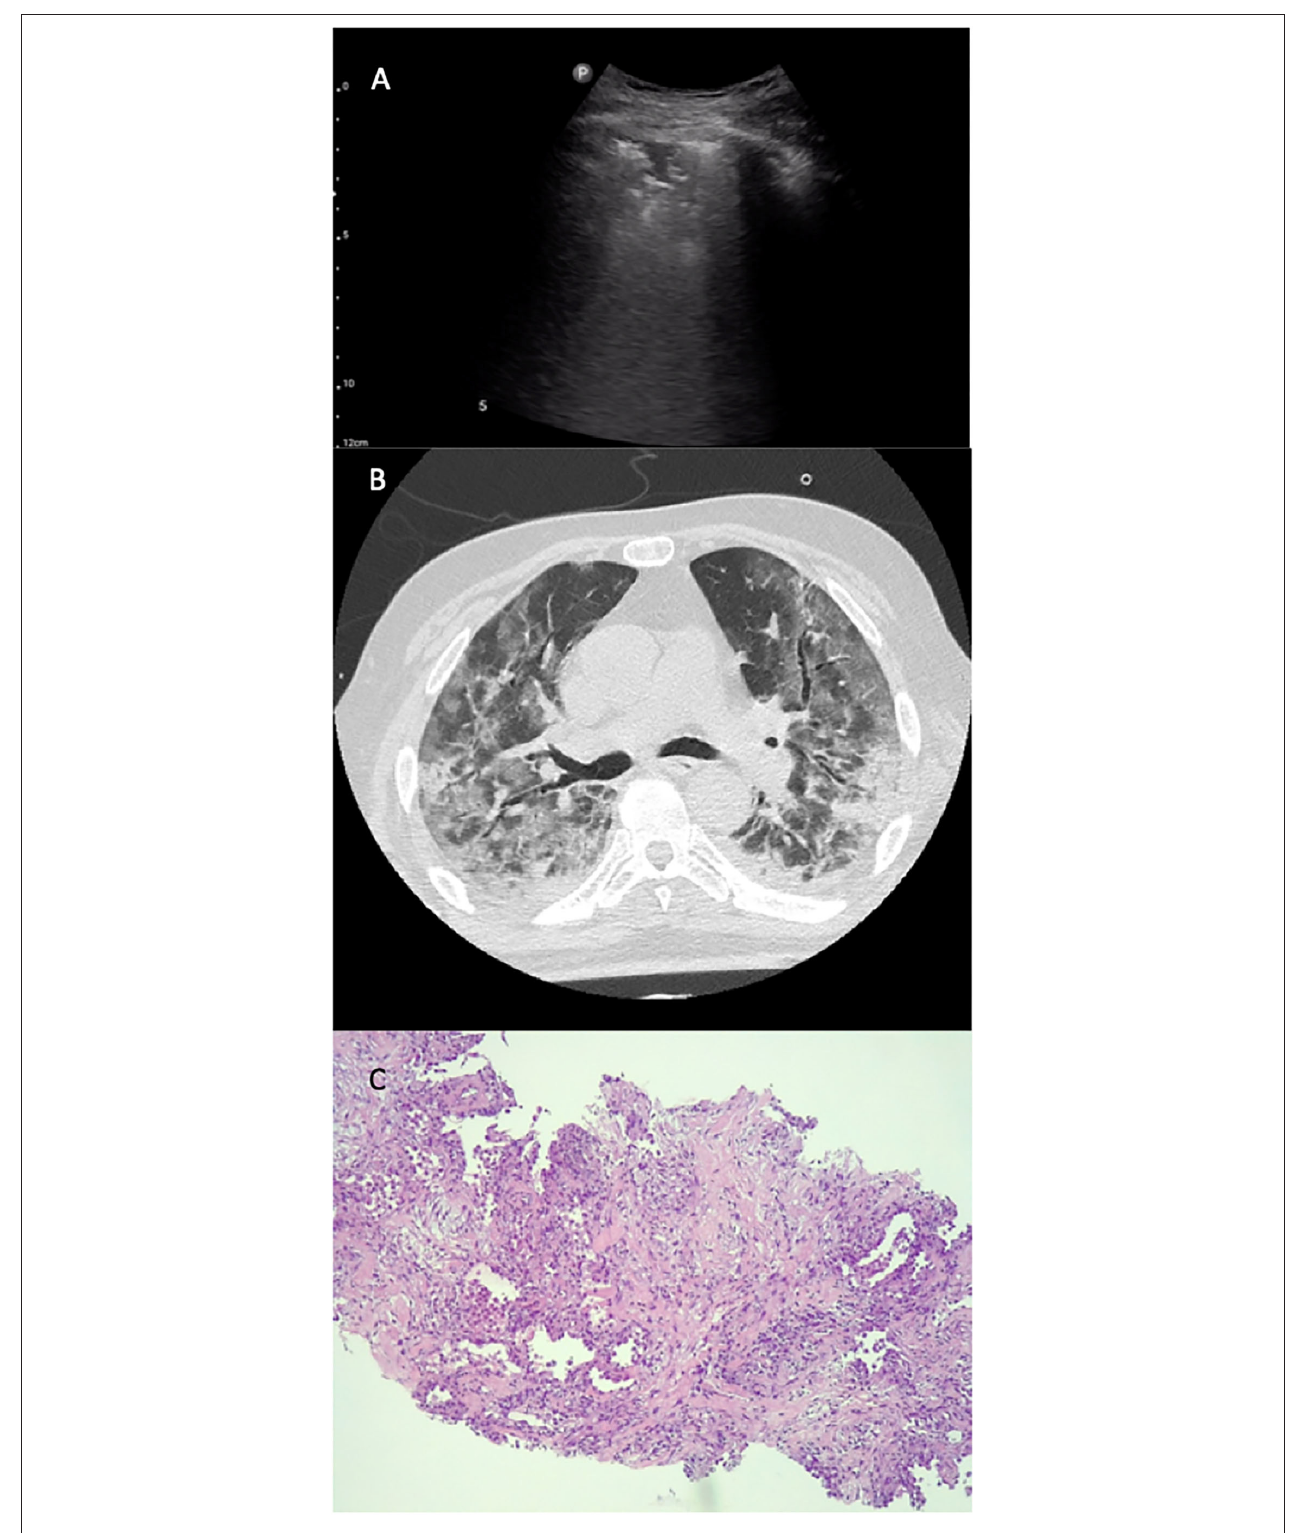
FIGURE 4 | LU–CT–histology from the same region. LU (A) , CT-scan (B) , and histological (C) images of the same patient. The LU exploration (A) shows a C-profile pattern, seen in the anterior left region of the thorax; CT scan (B) shows areas of ground-glass opacity in the same region. In the histological sample (C) , we observe an AFOP-like fibrotic DAD (focal organizational changes, interstitial deposition of collagen accompanied by pneumocyte type II hyperplasia).